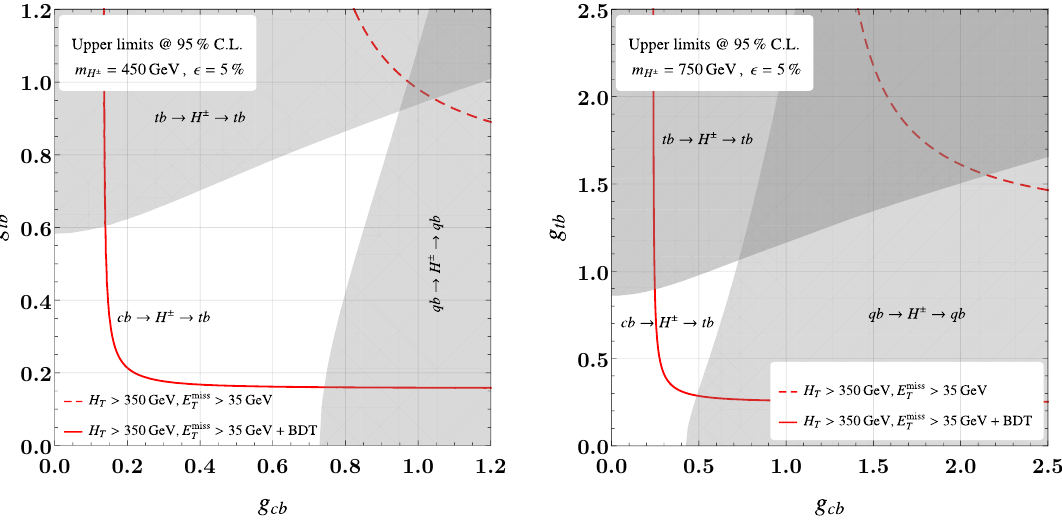
Figure 16 . Expected 95% CL upper limits in the coupling plane g cb – g tb for 140 fb − 1 and charged Higgs masses of 450 GeV (left panel) and 750 GeV (right panel). Shown are the constraints from single coupling searches based on dijet searches [62] denoted by “ qb → H ± → cb ”, and searches for top charged Higgs production and decay [57] denoted by “ tb → H ± → tb ”. The red lines denoted by “ cb → H ± → tb ” indicate the parameter space that could be probed by the search described in section 3.4. The dashed red line shows the constraints from applying the indicated cuts, while the solid line shows the constraints obtained from optimized cuts using a BDT algorithm. We assume a systematic uncertainty of 5%.